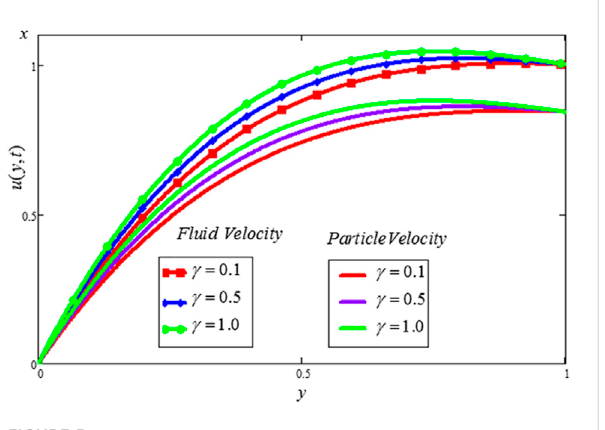
FIGURE 8 Effect of K 1 on u ( y , t ) and v ( y , t ) . When Pe (cid:2) 2 , M (cid:2) 0 . 5 , Gr (cid:2) 5 , ϕ (cid:2) 2 , γ (cid:2) 1 , K β (cid:2) 0 . 5 , t (cid:2) 1 , ω (cid:2) 0 . 5 and ε (cid:2) 0 . 001